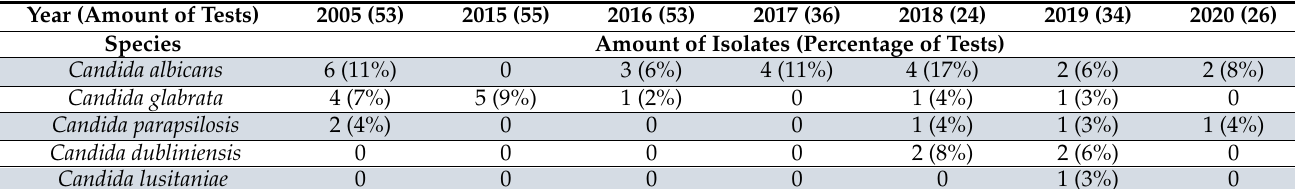
Table 4. Yeast species isolated from the urinary tract in the studied years.